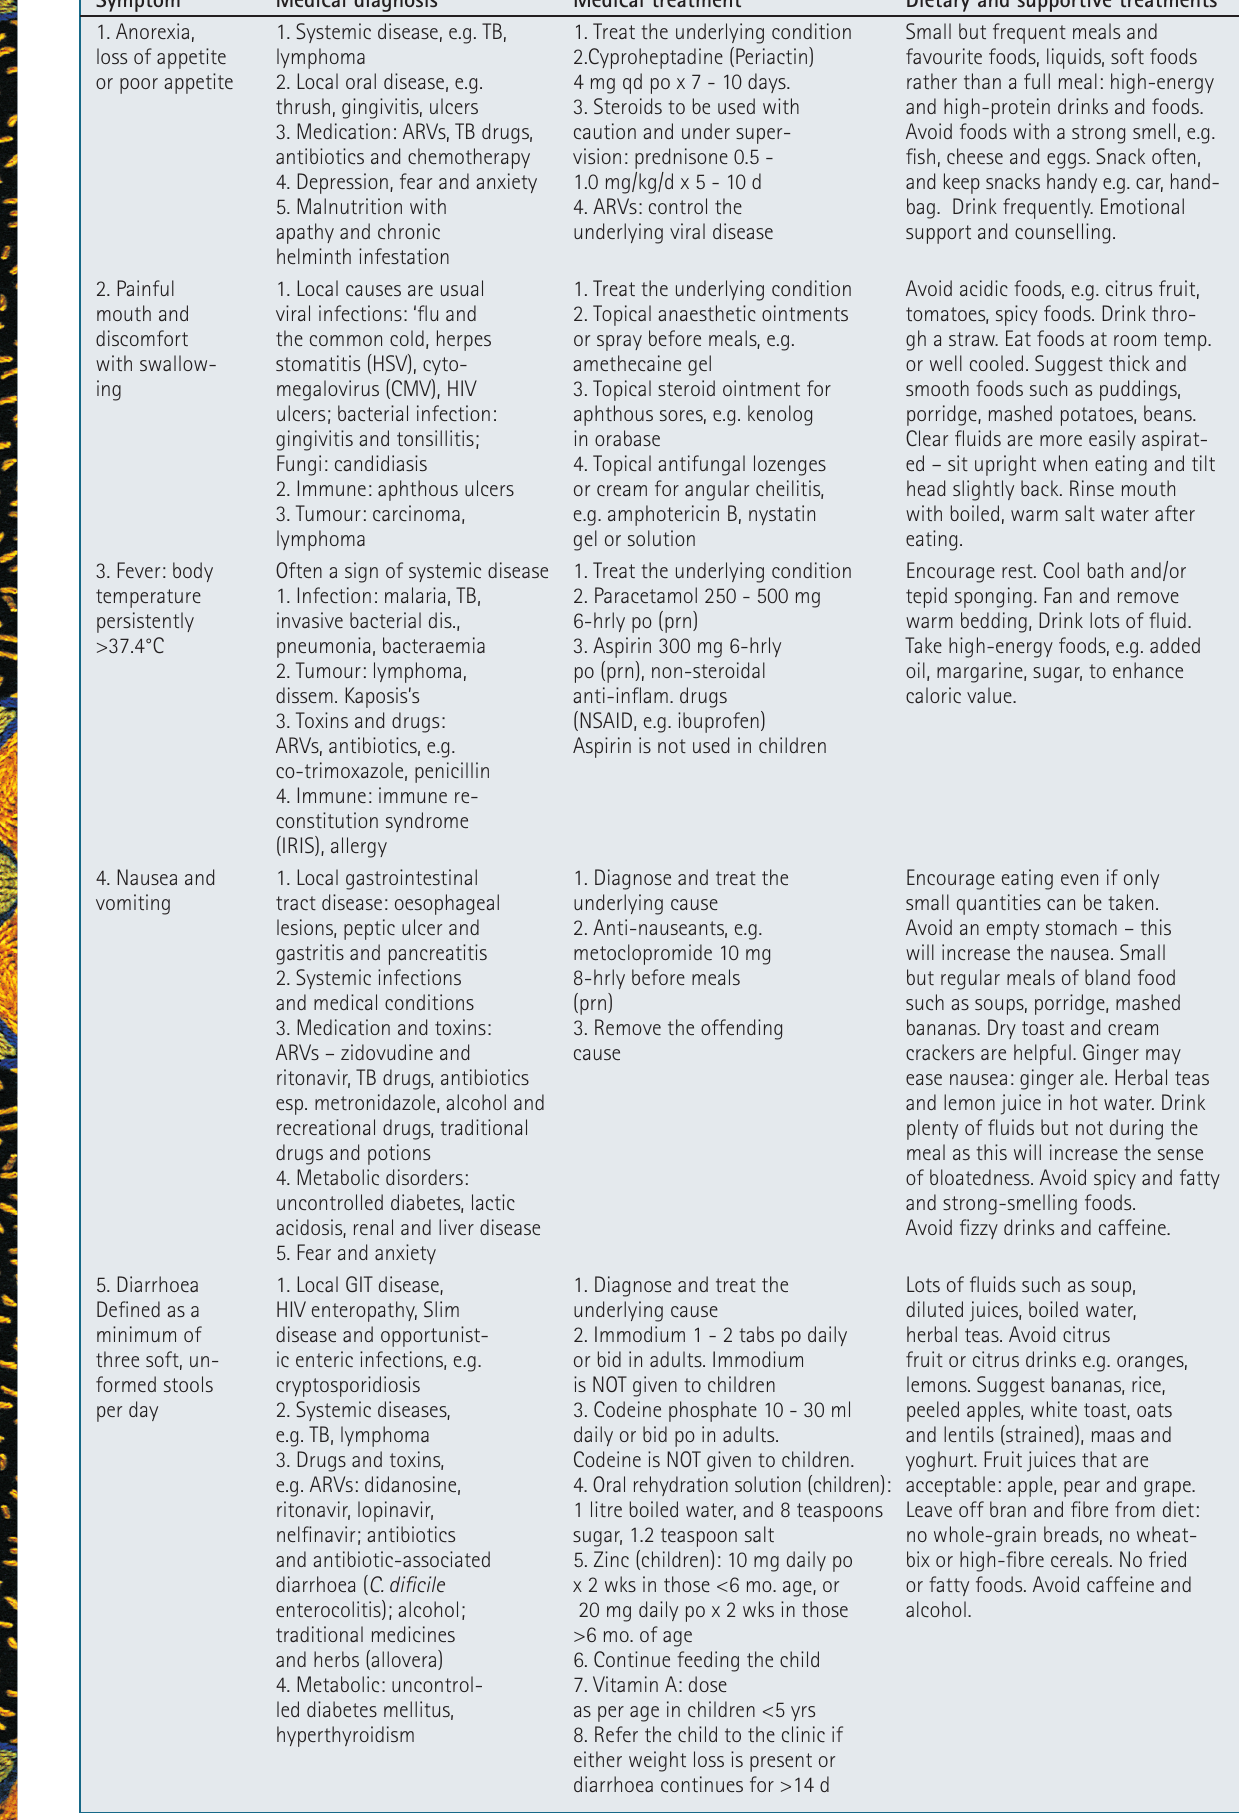
TABle 3.I. NUTRITIONAl AND ‘COMMONseNse’ APPROACHes TO sYMPTOM CONTROl